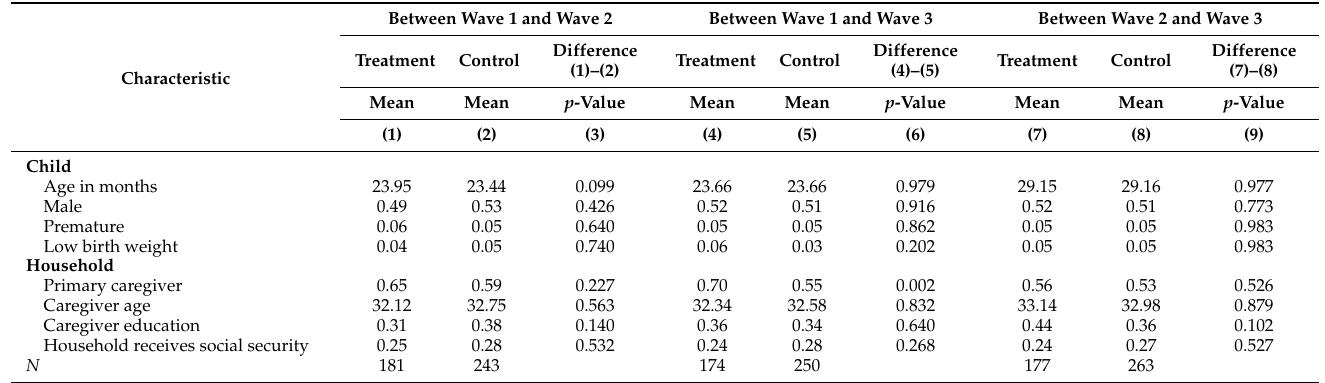
Table 1. Comparison of mean characteristics of treatments and comparisons (treatments: strengthened parental beliefs; comparisons: stable low parental beliefs).